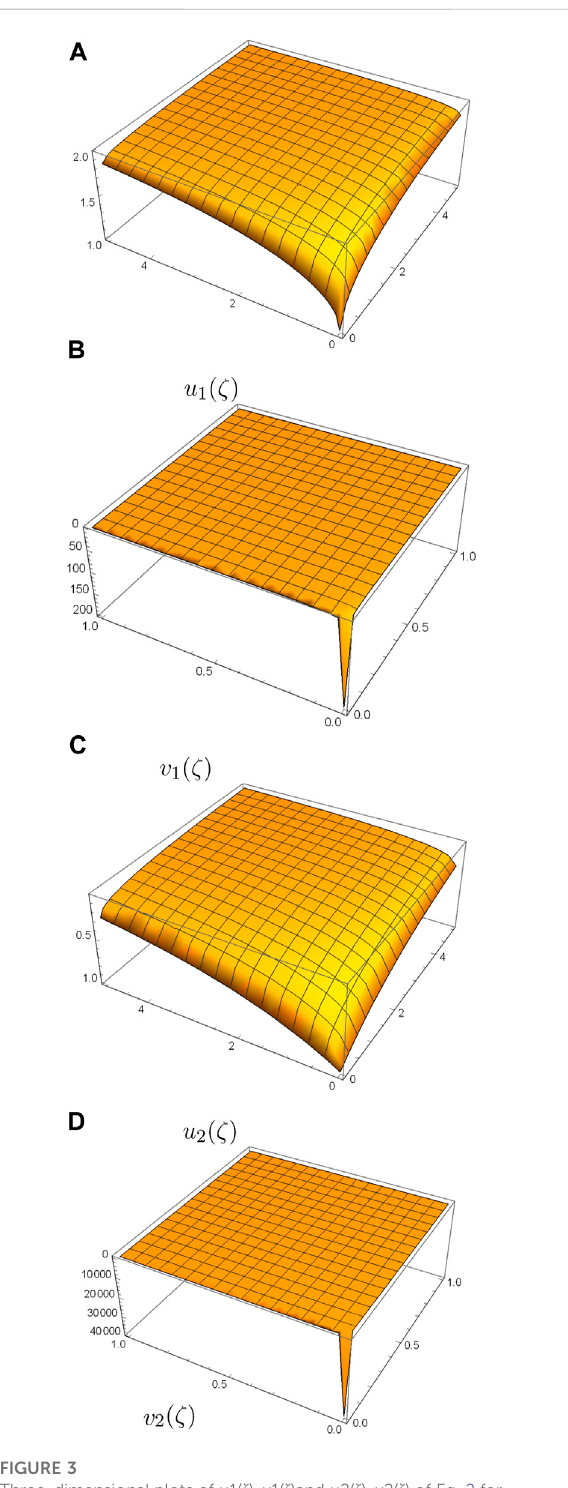
FIGURE 3 Three-dimensional plots of u1( ζ ), v1( ζ )and u2( ζ ), v2( ζ ) of Eq. 2 for η =0.5, a =1, l =1, k =1, L